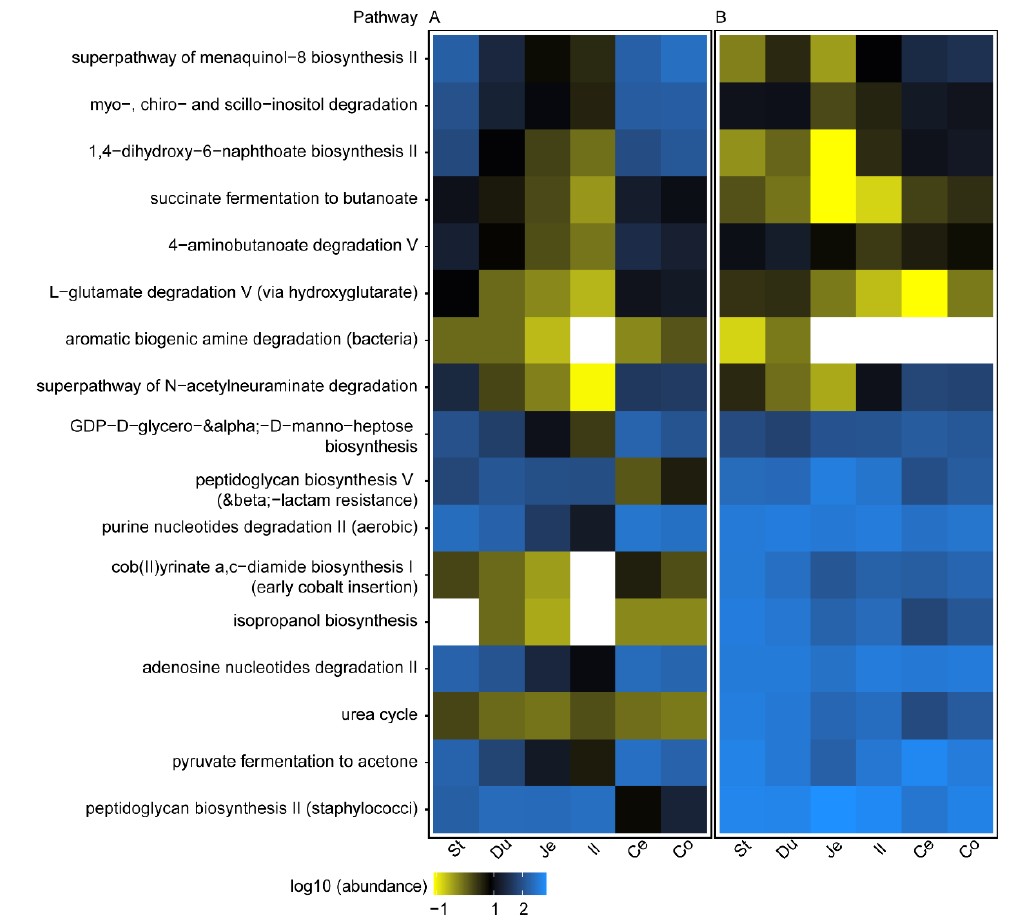
Figure 7. A heat-map representation of differentially abundant predicted pathways between segments of mice gastrointesti- nal tract of ( A ) standard or ( B ) western diet. Differential abundant MetaCyc pathways were identified using analysis of the composition of microbiomes (ANCOM) method. Only statistically significant pathways that fall within a distribution cut-off based on W values are shown (Table S5B for W values). The absence of pathway is shown as white. The mean abundance (rarefied to 132,892 counts per sample) is shown. St: stomach; Du: duodenum; Je: jejunum; Il: ileum; Ce: cecum; Co: